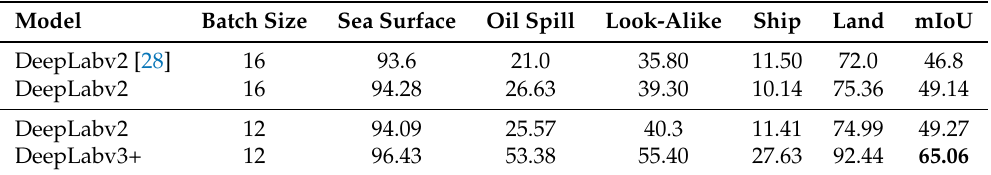
Table 6. Comparison of DeepLab